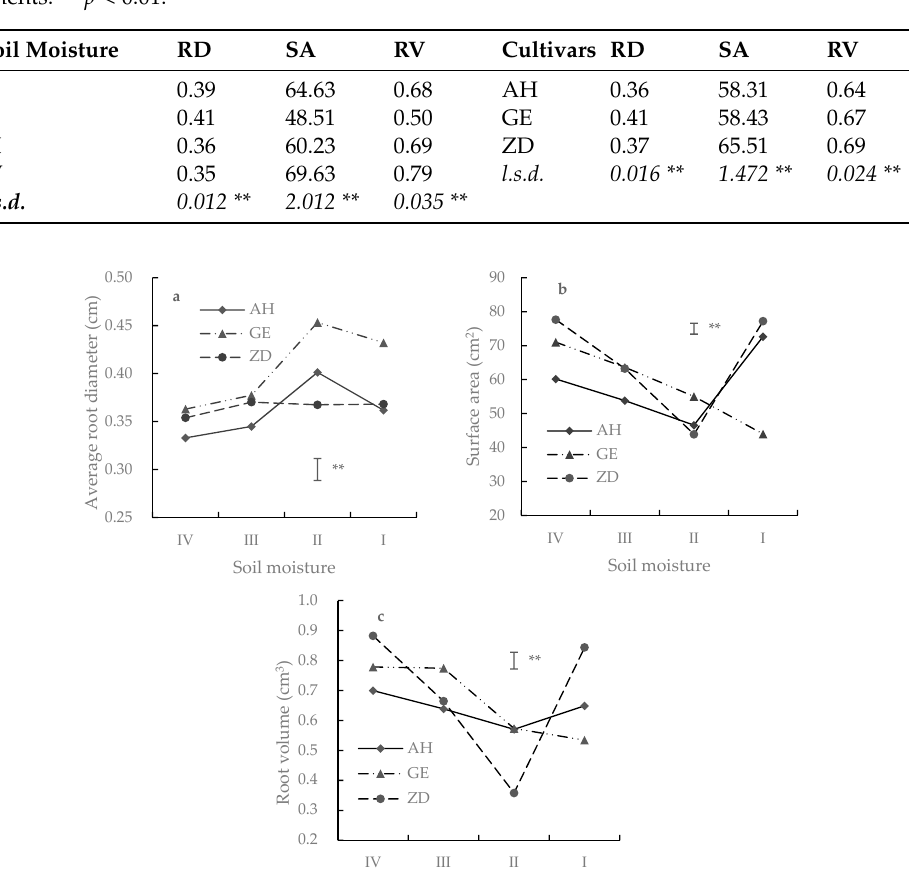
Table 8. Average root diameter (RD; cm), root surface area (SA; cm 2 ) and root volume (RV; cm 3 ) under various soil moisture (See Table 1 for soil moisture abbreviations) and cultivar (AH, GE and ZD) treatments. ** p < 0.01.